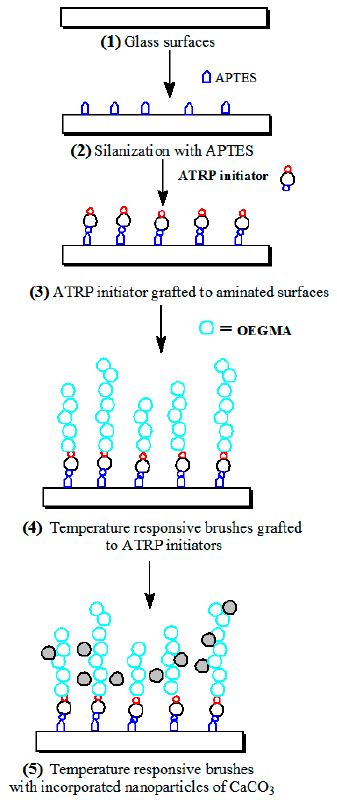
Scheme 1. Functionalization of glass surface ( 1 ) with amino-terminated